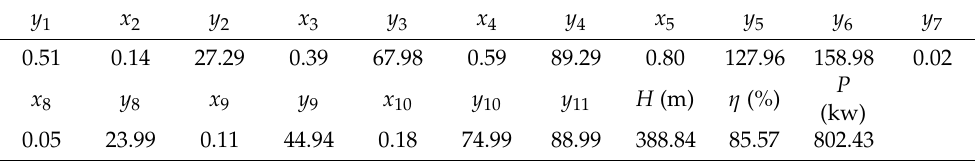
Table 5. Design variables and external characteristic data of the optimal solution.